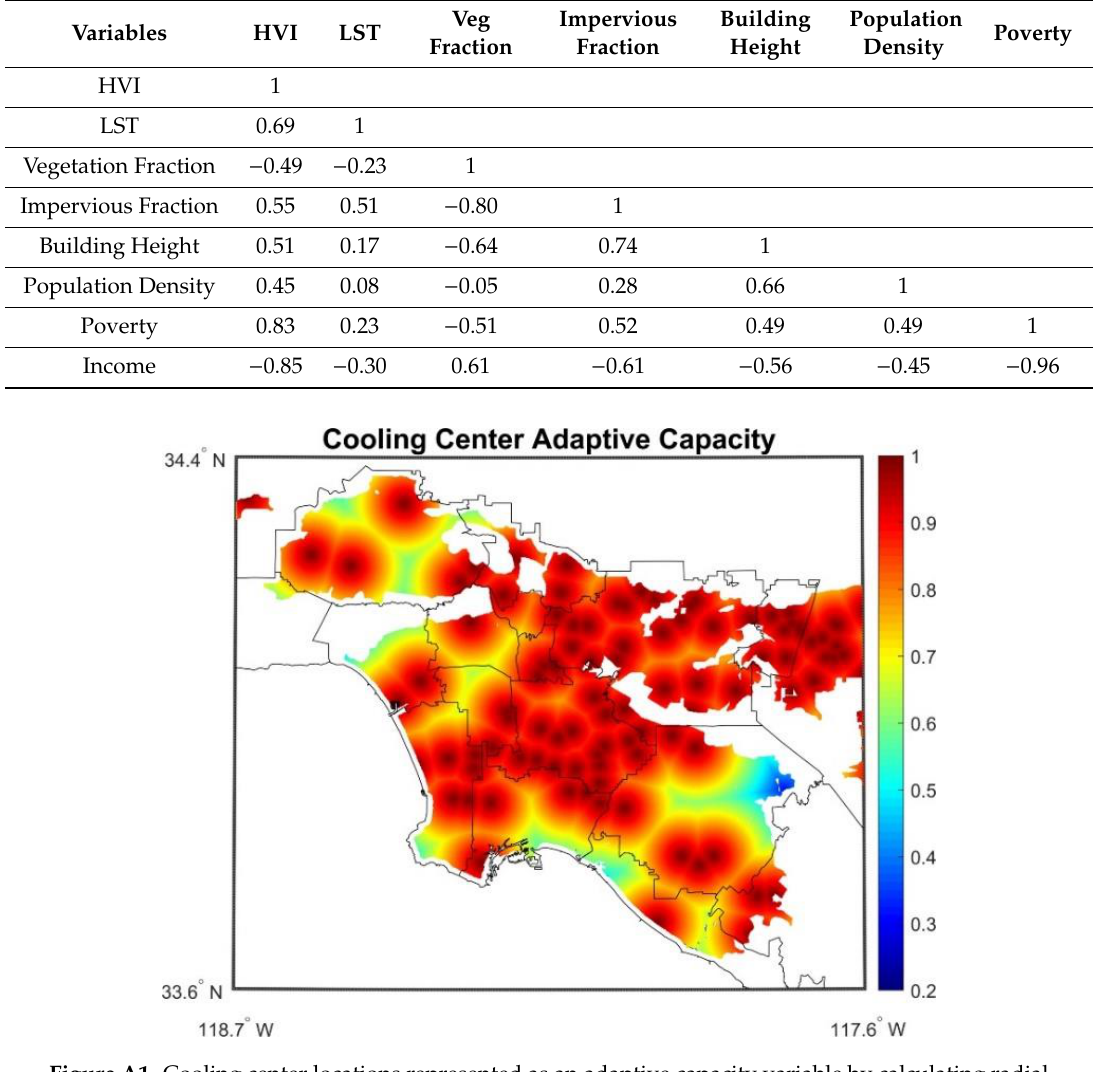
Table A2. Correlation coefficients of selected variables used in the HVI analysis.